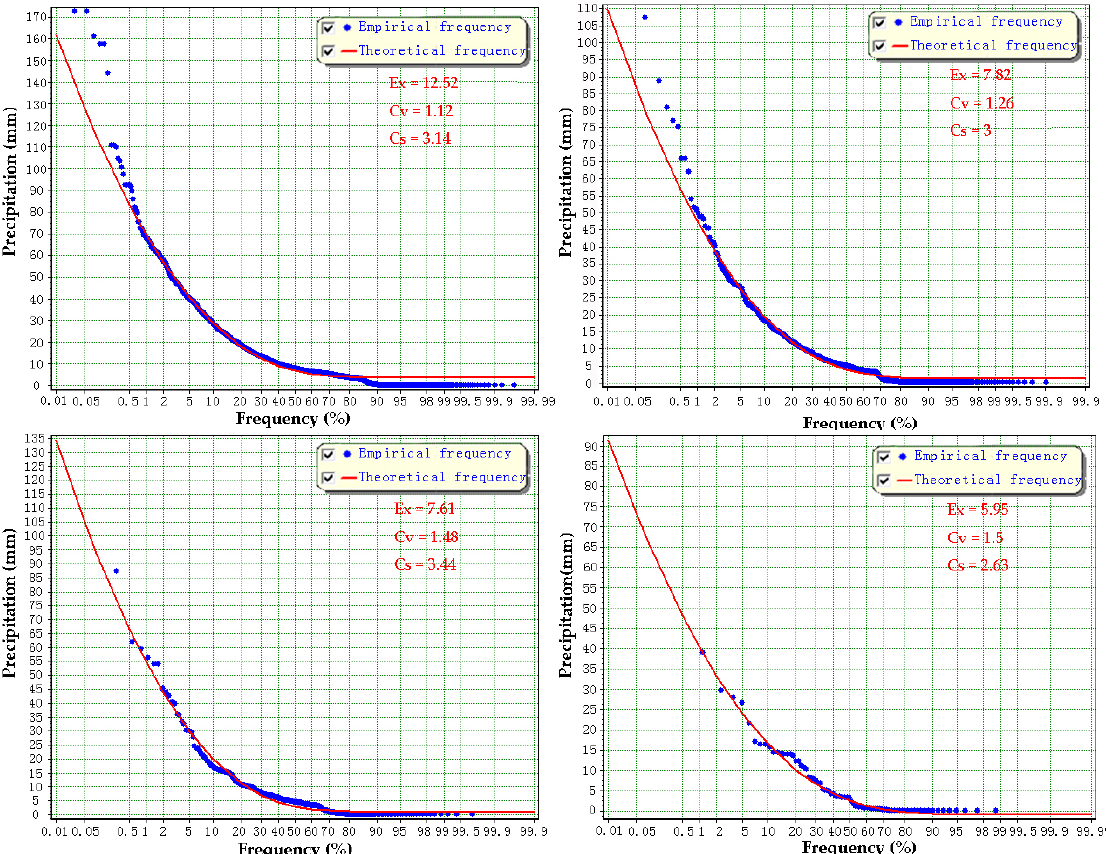
Figure 11. The Pearson-III frequency of the first precipitation after ( a ) light drought; ( b ) moderate drought; ( c ) severe drought; and ( d ) extreme drought in region I.